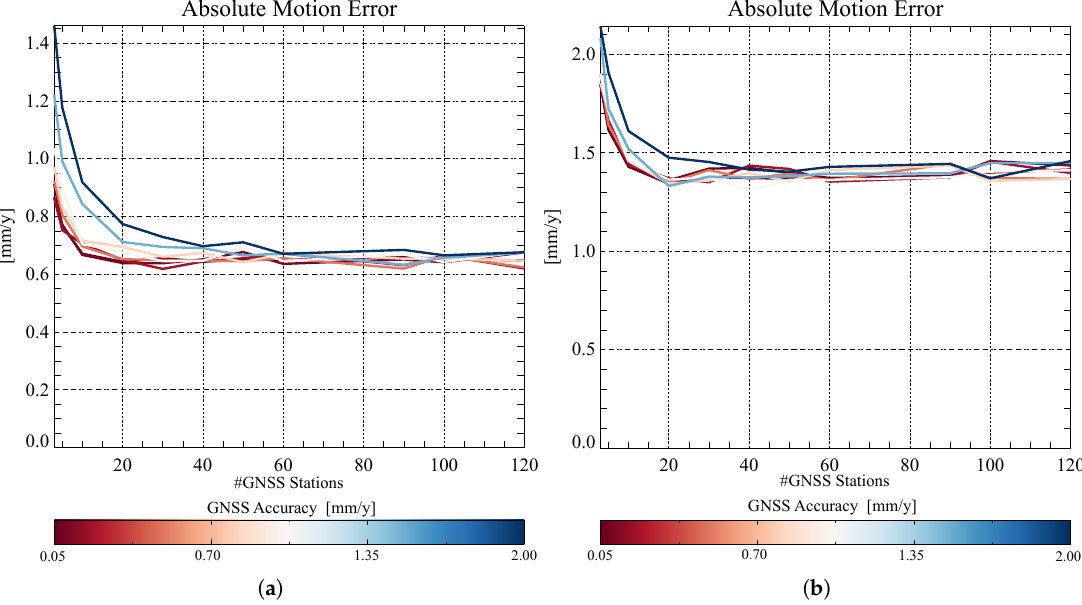
Figure 4. Performance simulations in retrieving (cid:98) v ref carried out with different atmospheric noise sills: ( a ) σ 2 α = 2 mm 2 /y 2 and ( b ) σ 2 α = 9 mm 2 /y 2